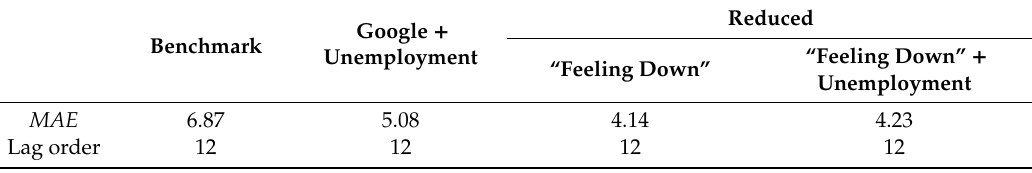
Table 4. Statistical models result for the NN